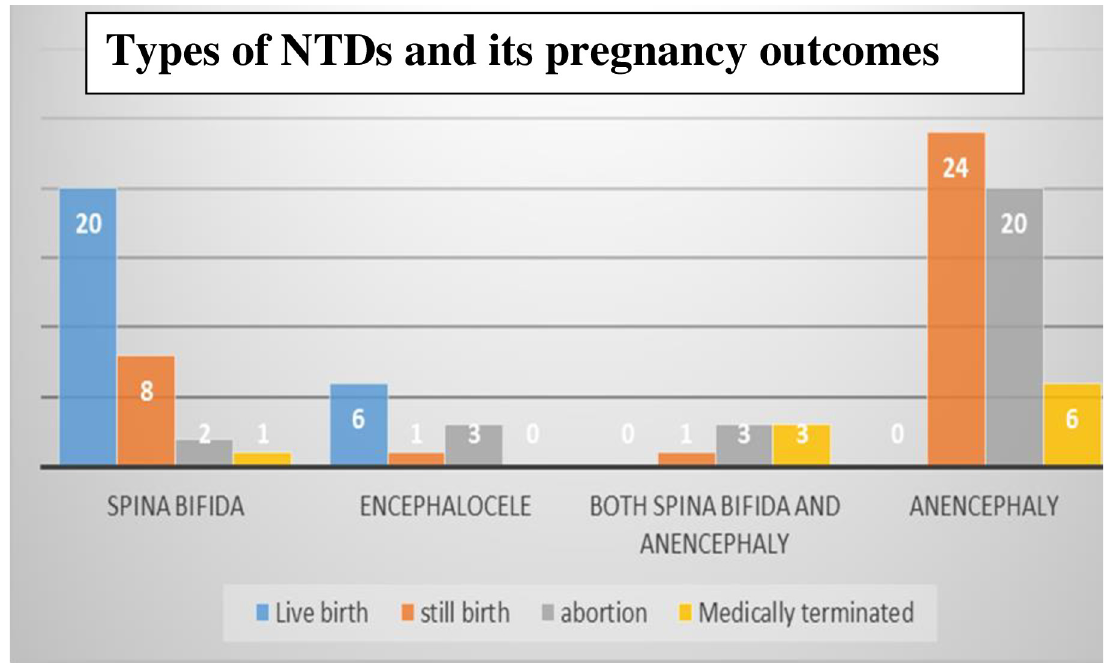
Fig 1. Types of NTDs and its pregnancy outcomes at Debre Berhan Referral Hospital, from August 30, 2017 to August 30, 2019 ( n = 97). Stillbirth is delivery of dead fetus after 20 th week of development. Abortion is ending of pregnancy before 20 th week of development. Medically terminated means ending of pregnancy for medical